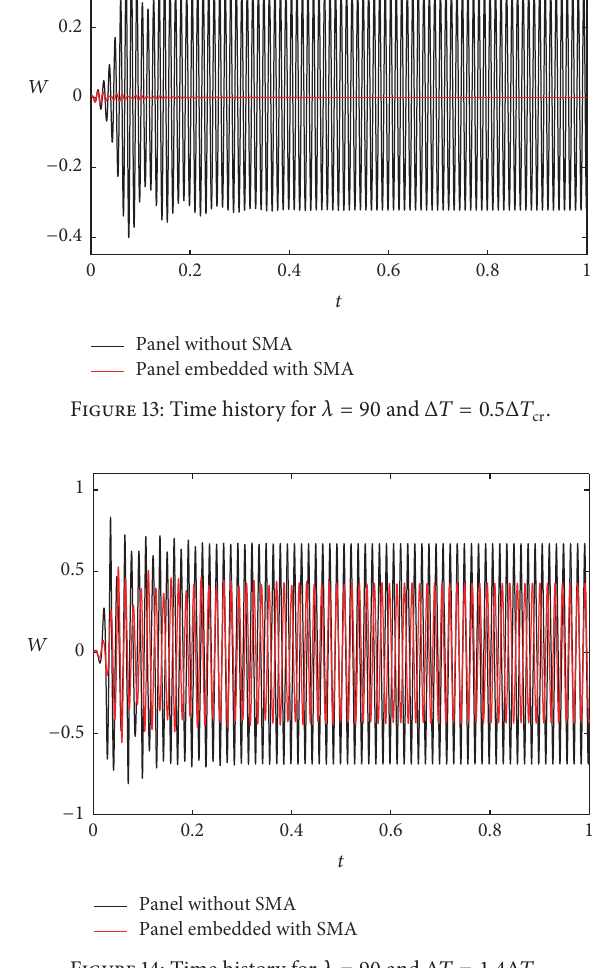
Figure 14: Time history for 𝜆 = 90 and Δ𝑇 = 1.4Δ𝑇 cr .